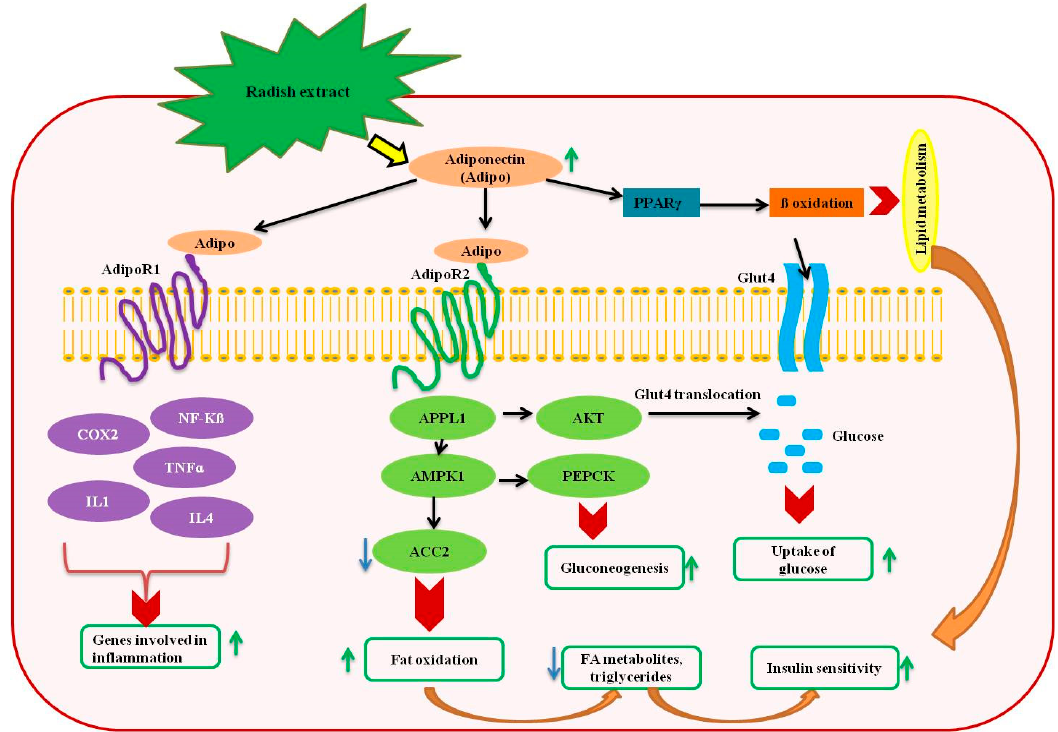
Figure 2. A schematic representation of anti-diabetic mechanisms induced by the radish extracts.